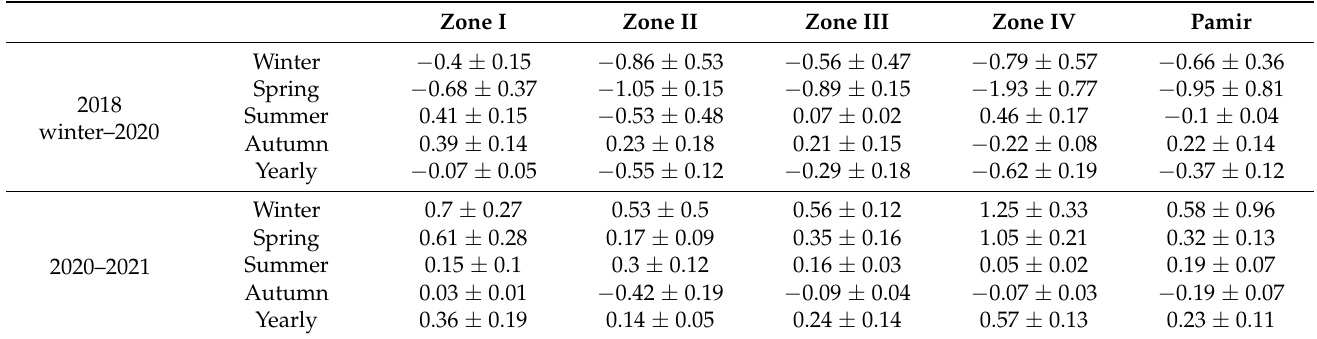
Table 1. Seasonal variations in GSE in Zones I–IV of the Pamir (units: m). Zone I Zone II Zone III Zone IV